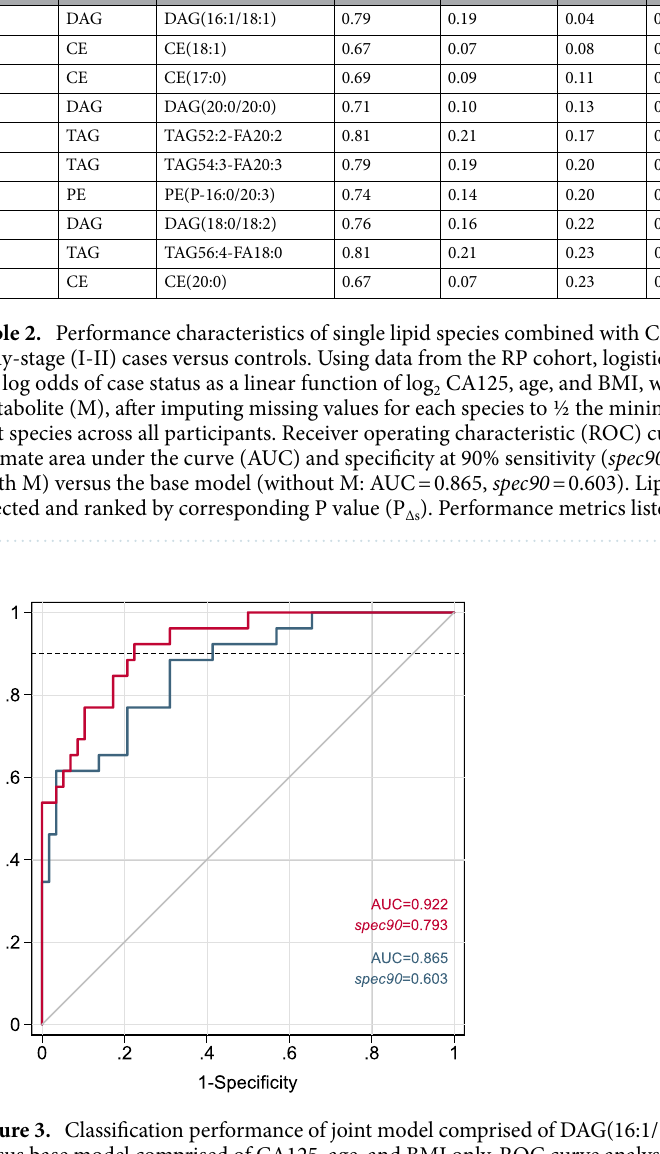
roles for increased lipid uptake in ovarian malignancies 8,10,11 , we focused our differential expression analysis on ~ 150 genes related to lipid transport (Table S8). Our meta-analysis of four independent datasets encom- passing 106 malignant and 51 benign ovarian samples revealed 37 genes differentially expressed by case group at FDR < 0.05. 13 genes remained significant after Bonferroni correction and showed two-fold or greater fold changes (Fig. 4). Notably, among the largest expression changes observed were for two genes encoding cell-sur- face lipoprotein receptors, LSR (lipolysis stimulated receptor) and VLDLR (very low density lipoprotein recep- tor). While LSR expression was elevated in malignant versus benign tumors, VLDLR expression was reduced. These intriguing findings indicate that expression of specific lipid transporter genes represents a distinguishing feature of ovarian cancers relative to benign tumors, and further suggest that tumor biological differences in lipid uptake may underlie observed alterations in plasma lipid profiles in women with these distinct clinical conditions.